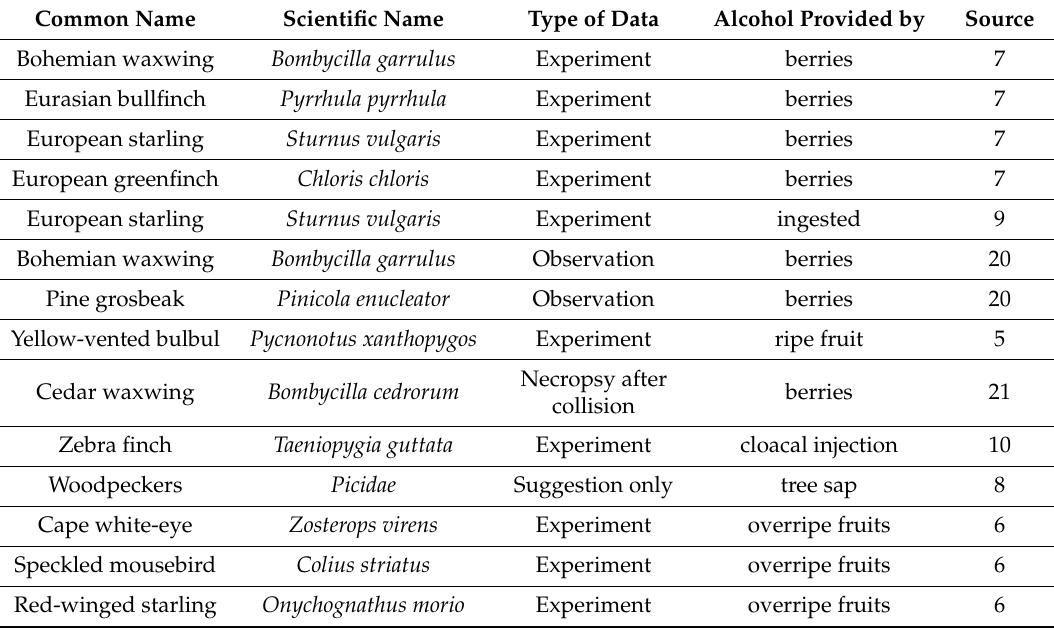
Table 1. Interactions between birds and alcohol provided in di ff erent forms reported in the scientific literature. Sources are arranged from oldest to